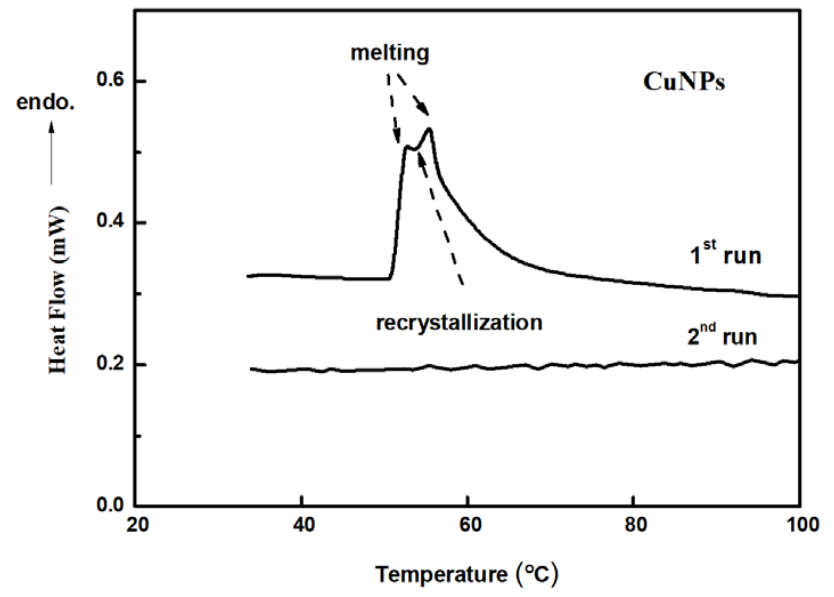
Figure 6. Differential scanning calorimeter (DSC) thermograms of Cu-NPs prepared with TETA/Cu 2+ = 2.5 / 1.